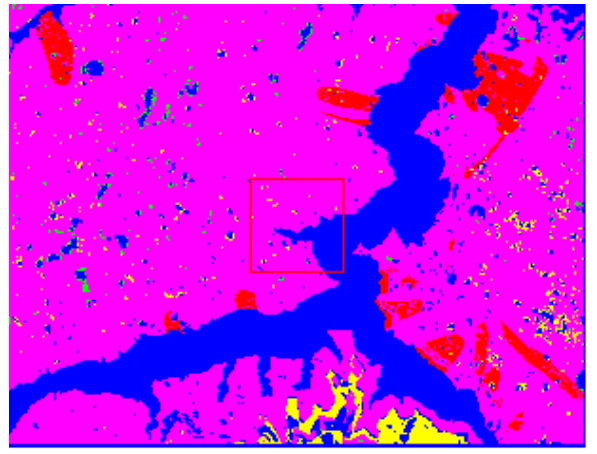
Figure 23. Forecast result of Parallelepiped.